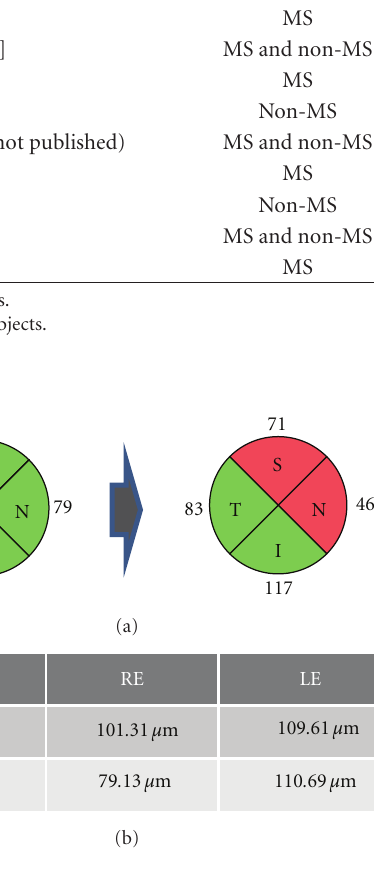
Figure 2: Patient who developed retrobulbar neuritis in his right eye as an initial clinically isolated syndrome. In only three months, axonal loss can be detected in the eye that su ff ered the